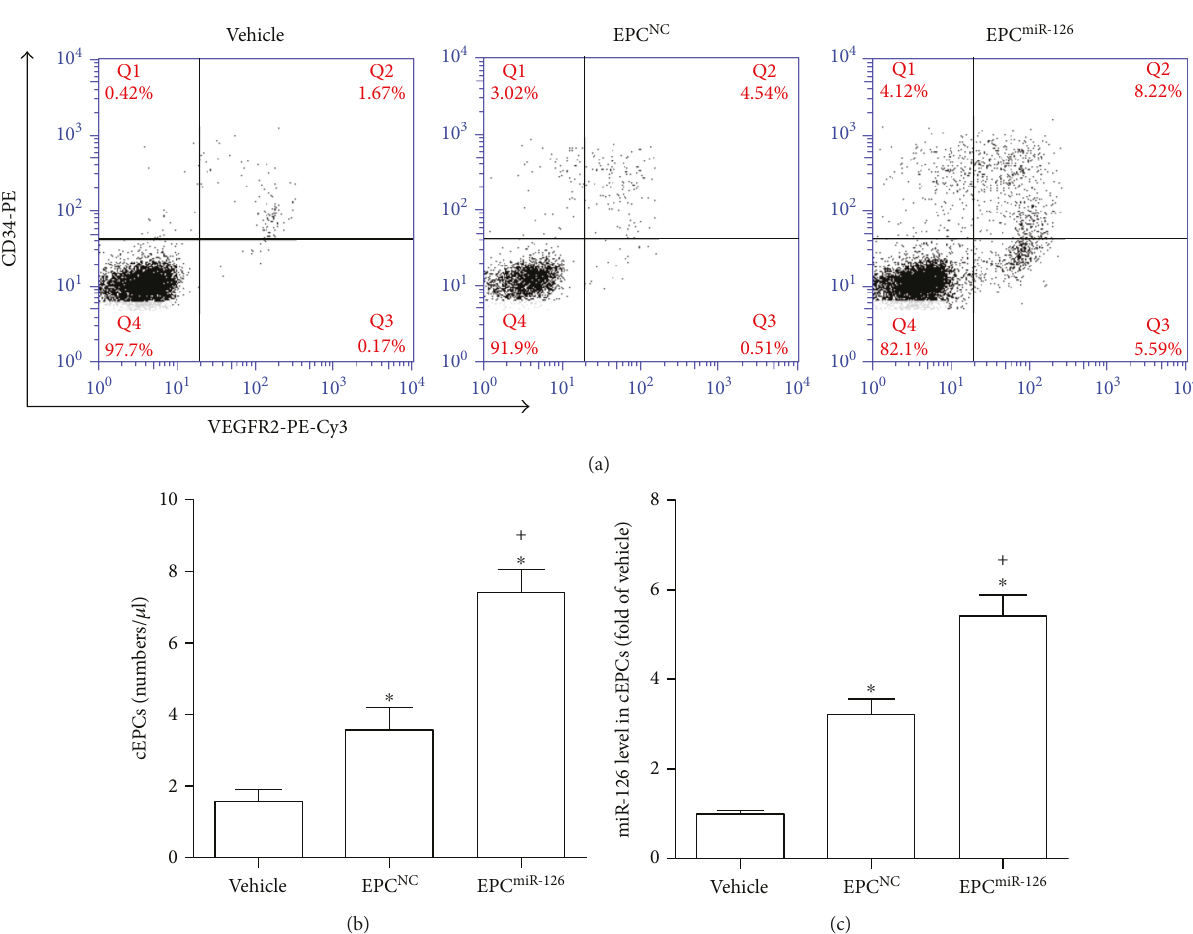
Figure 7: miR-126 priming enhances the e ffi cacy of EPCs in increasing cEPCs and the level of miR-126 of cEPCs in MCAO mice. (a) Representative fl ow cytometry plot of the levels of cEPCs in each group. (b) Summarized data on the levels of cEPCs. (c) The miR-126 level of cEPCs in MCAO mice in each therapeutic group. ∗ p < 0 05 versus vehicle; + p < 0 05 versus EPC NC . cEPCs: circulating EPCs, n = 10